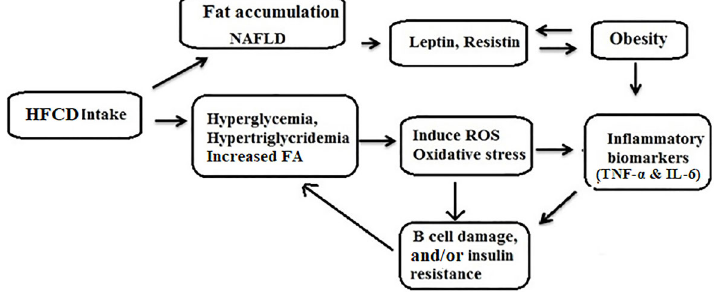
Figure 2. Mechanism of action of the high fat-carbohydrate diet (HFCD), oxidative stress, insulin resistance, and in fl ammatory markers. Mechanism of action of the different treatment groups: Biochemical cascade and mechanism of HFCD intake on the induction of reactive oxygen species (ROS) generation and in fl ammatory biomarkers (TNF- a , IL-6, obesity, free fatty acids (FFA), leptin, and insulin resistance). Interference with insulin resistance leads to hyperglycemia and in fl ammatory biomarkers changes (increased TNF- a and IL-6) lead to the inhibition of insulin signaling and insulin resistance. Also, in fl ammation in B cells leads to B cell dysfunction, which in combination with insulin resistance, results in type 2 diabetes mellitus. NAFLD: non-alcoholic fatty liver disease.